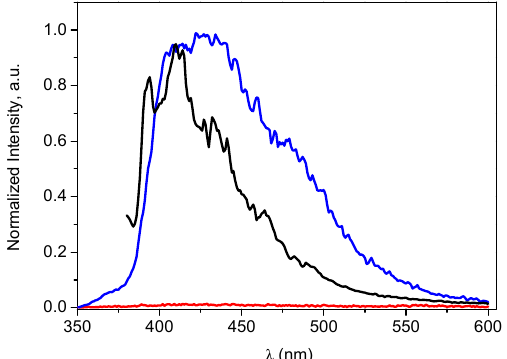
Figure 8. Phosphorescence emission spectra of DCF (red), the AB-DCF dyad (blue), and AB-Me (black) in ethanol at 77 K at the excitation wavelength λ exc of ca. 284 nm.